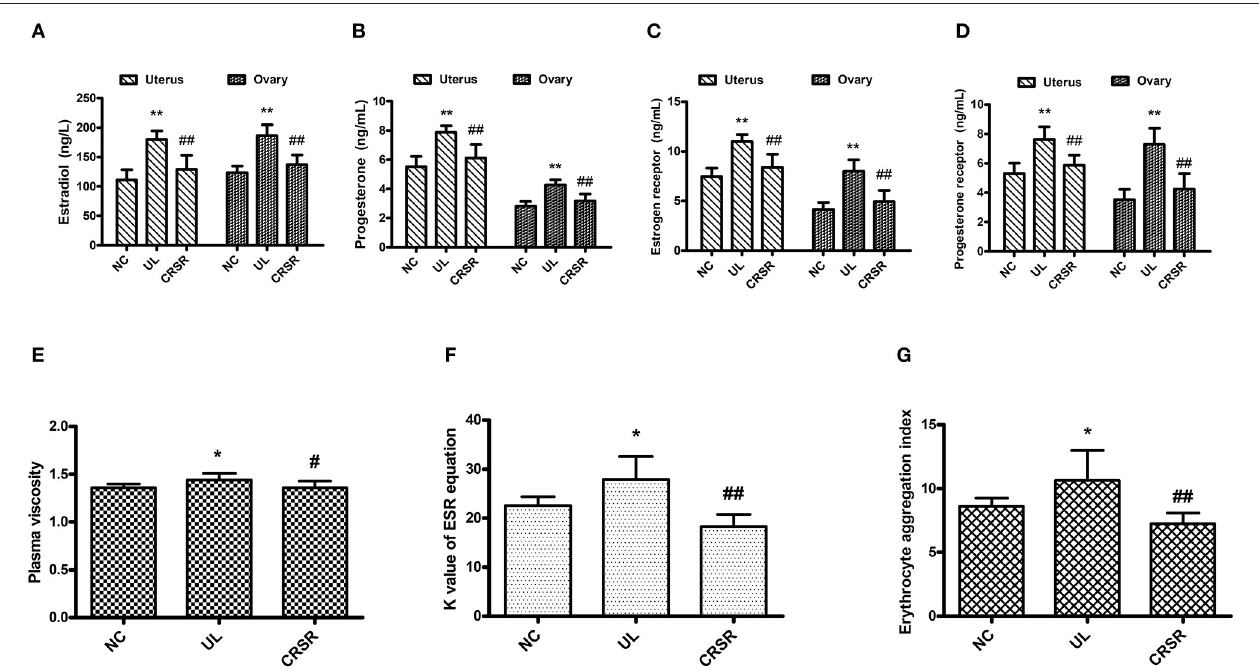
FIGURE 4 | CRSR reduced the levels of key hormones and receptors of UL. (A) , estradiol (E 2 ); (B) , progesterone (P); (C) , estrogen receptor (ER); (D) , progesterone receptor (PR). (E–G) Effects of CRSR on hemorheology. (E) , PV; (F) , K value of ESR equation; (G) , EAI. Data are reported as mean ± SD. NC, normal control group; UL, uterine leiomyoma model group; CRSR, Curcumae Rhizoma and Sparganii Rhizoma treatment group. * p < 0.05, ** p < 0.01 UL vs. NC; # p < 0.05, ## p < 0.01 CRSR vs. UL (Kruskal–Wallis H